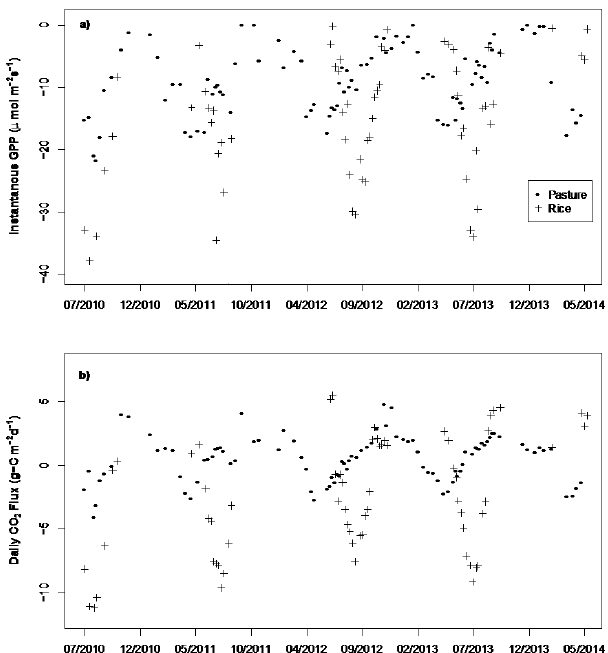
Figure 2. Instantaneous gross primary productivity (GPP) and daily net CO 2 flux on the hyperspectral canopy reflectance sampling dates. Both the Pasture and the Rice exhibited strong seasonal pat- terns with peak CO 2 uptake mid-year. However, the Pasture experi- enced peak CO 2 uptake that preceded the peak for the Rice, where the maximum CO 2 uptake occurred in March–April for the Pasture and in July–August for the